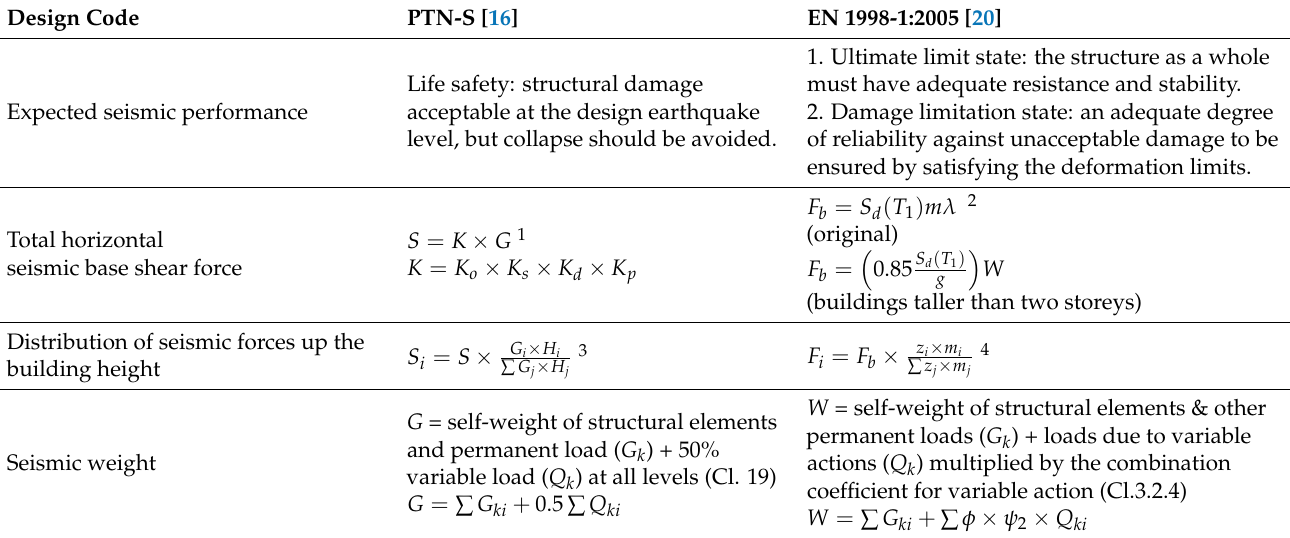
Table 1. Overview of relevant seismic design provisions for masonry buildings (1981–present).